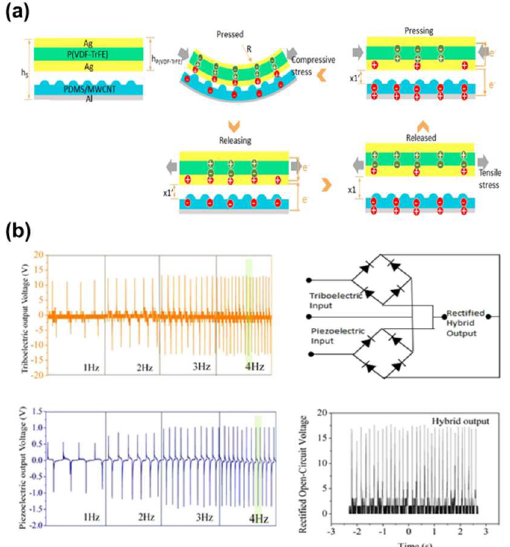
Figure 7. ( a ) The cross-section structural schematic; Charge distribution of triboelectric and piezoelectric effect during force pressing and releasing. Inside of the picture, 0 < x 1 ′ < x 1 , h s is the summation height of TPENG, h P (VDF-TrFE) is the height of P(VDF-TrFE) film, R is the stretching radius. ( b ) The open-circuit performance of the triboelectric and piezoelectric under the force of 5 N as a function of frequency. The circuit diagram of the hybrid output in which the piezoelectric and triboelectric outputs are combined in parallel. Hybrid open-circuit output voltage. Reproduced with permission from Luo et al., Sci. Rep. 2016 , 6 , 36409. Copyright 2016 Springer